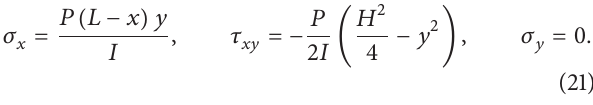
Figure 2: A patch with 13 nodes.